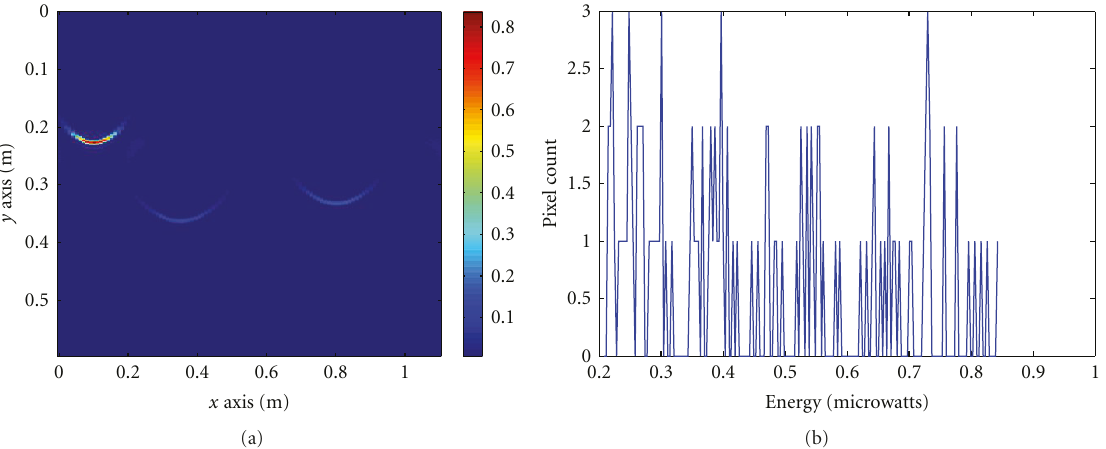
Figure 2: (a) Reconstructed data set using v = 1 . 5 v sim . (b) Image histogram.